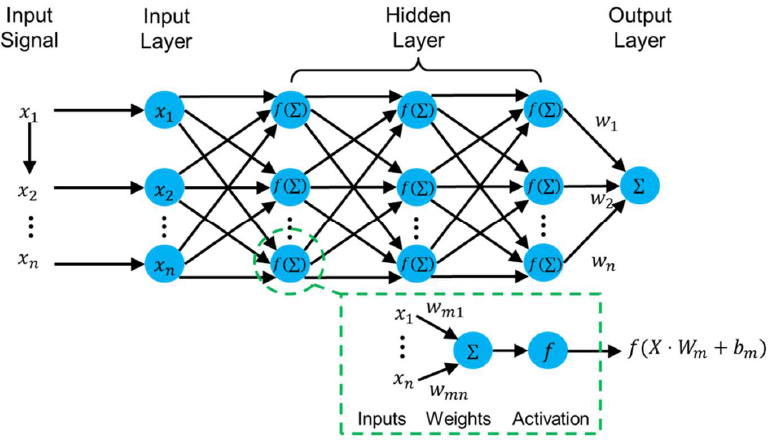
Figure 8. Structure of DNN.